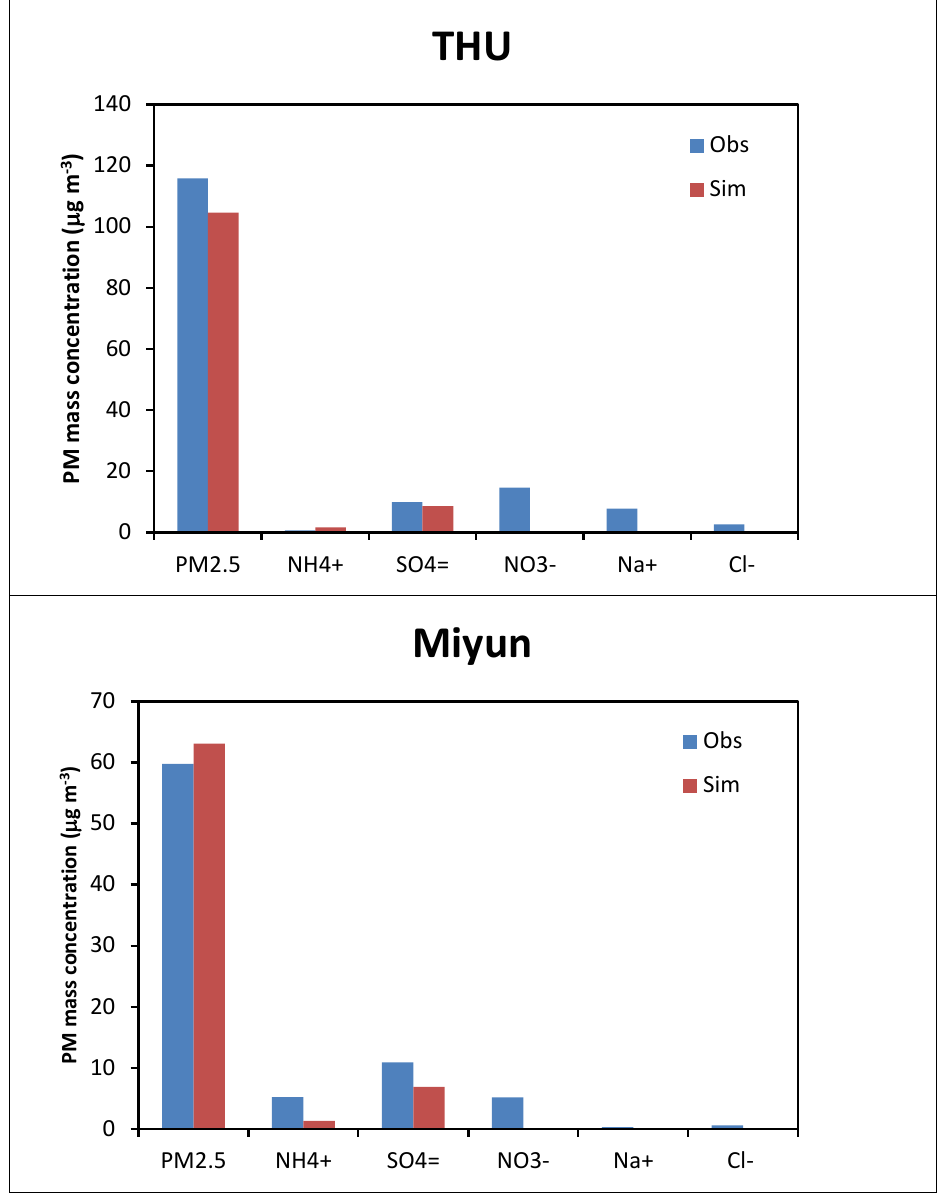
Figure 7. Simulated and observed surface concentrations of PM 2.5 and PM 2.5 composition at THU and MY sites in Beijing, China for the 2006 simulation with M92. WRF-CAM5 does not simulate NO 3−